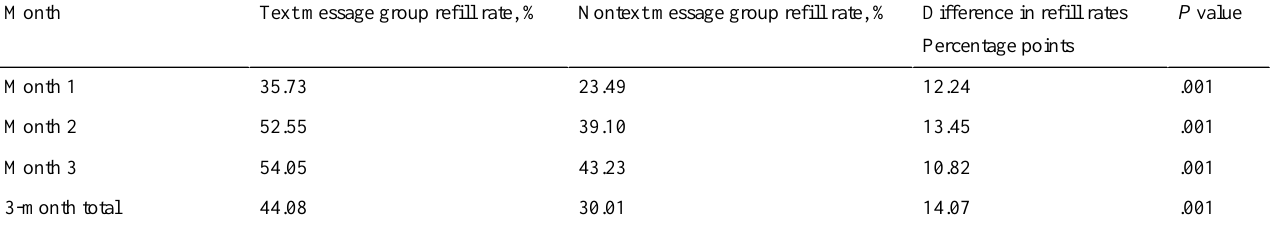
Table 4. Differences in refill rates between the text message and nontext message groups.